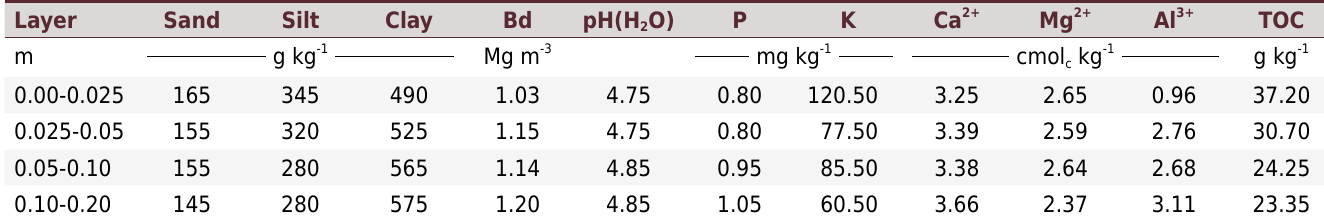
Sand, silt, clay: pipette method; Bd: bulk density (Claessen, 1997); pH in water, 1:1 ratio, v/v; P and K: Mehlich-1 extractant; Ca 2+ , Mg 2+ , Al 3+ : 1 mol L -1 KCl extractant; H+Al: 0.5 mol L -1 calcium acetate extractant at pH 7.0; TOC: total organic carbon (Tedesco et al.,